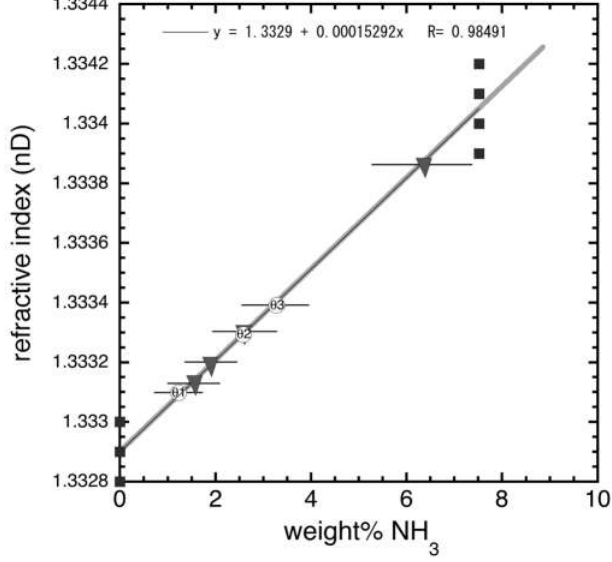
Figure A1. Refractive index vs. composition in the ammonia-water system. Measurements made on melted liquid from samples.